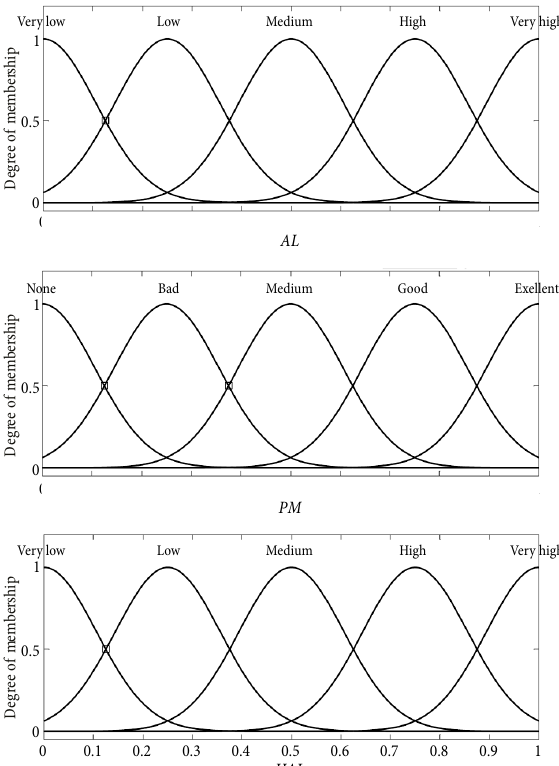
Fig. 6. The membership functions for AL , PM and HAL